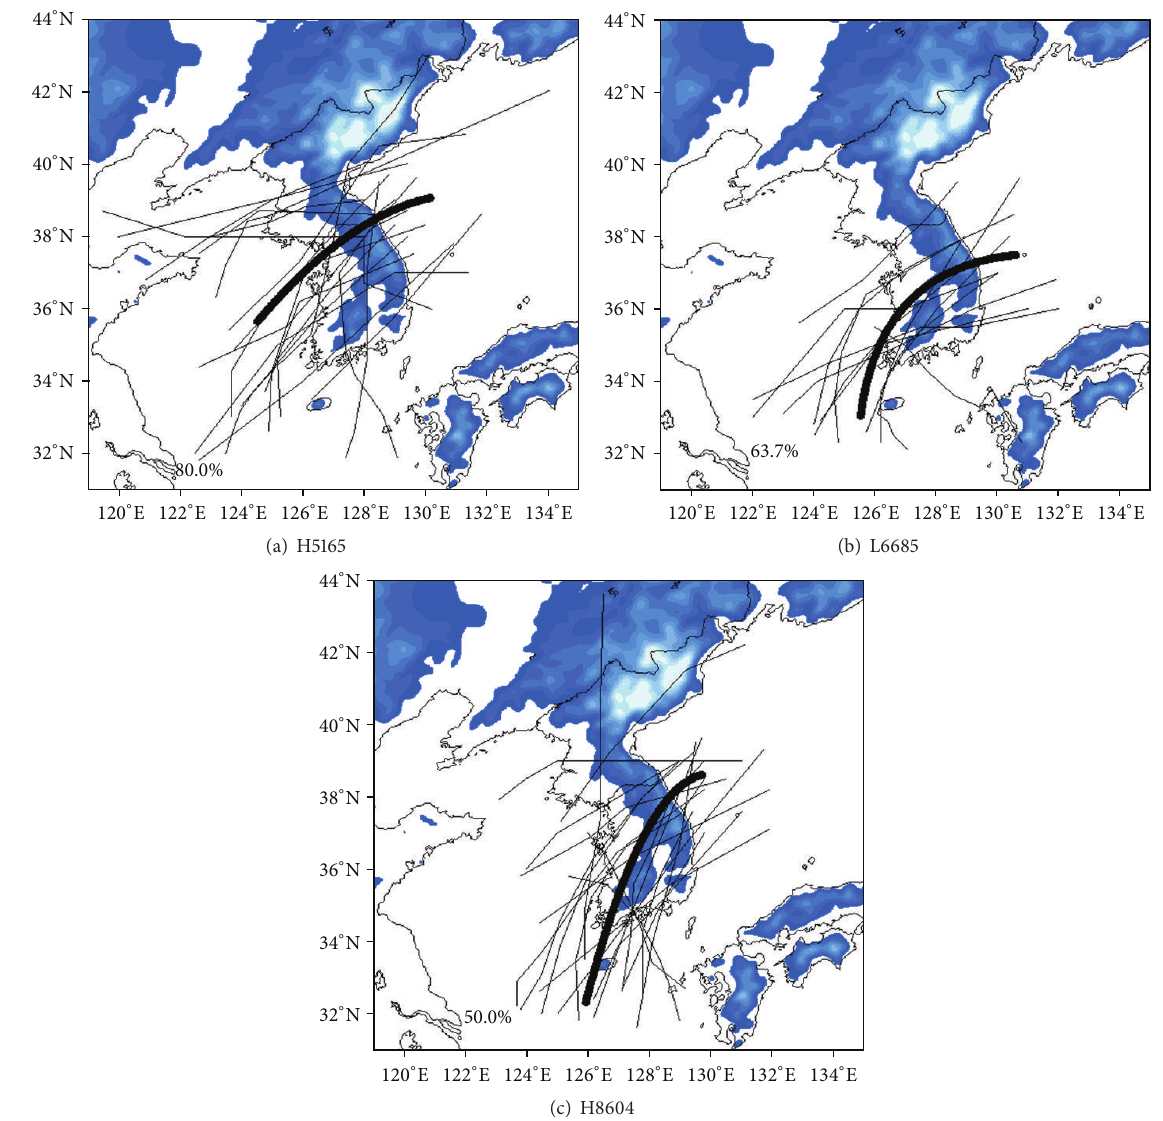
Figure 4: Landfalling (left) of a Korea-landfall TC for the periods of (a) H5165, (b) L6685, and (c) H8604. The thick lines denote the mean regression tracks and the number in the lower-left corner denotes the ratio of the landfalling TC frequency at the west coast of Korea to the total TC frequency in each period. Shaded areas indicate topography higher than 200